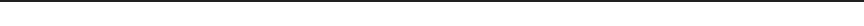
Table 3. Emilio and his mother Ana.